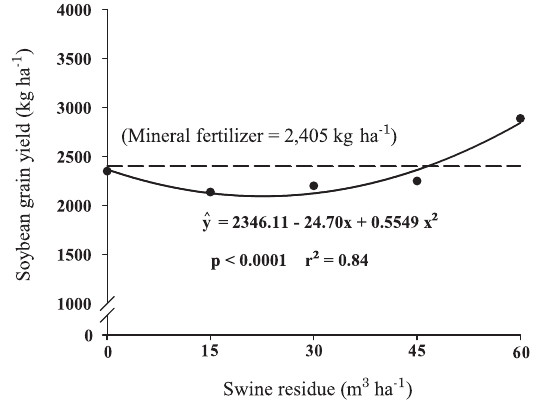
figure 5. Soybean grain yield (kg ha -1 ) at rates of 0, 15, 30, 45, and 60 m 3 ha -1 swine residue in the growing seasons 2005/2006 and with mineral fertilizer as recommended for soybean. table 4. Soil chemical properties in 2002 and 2006, in the 0–20 cm layers, as affected by swine residue rates